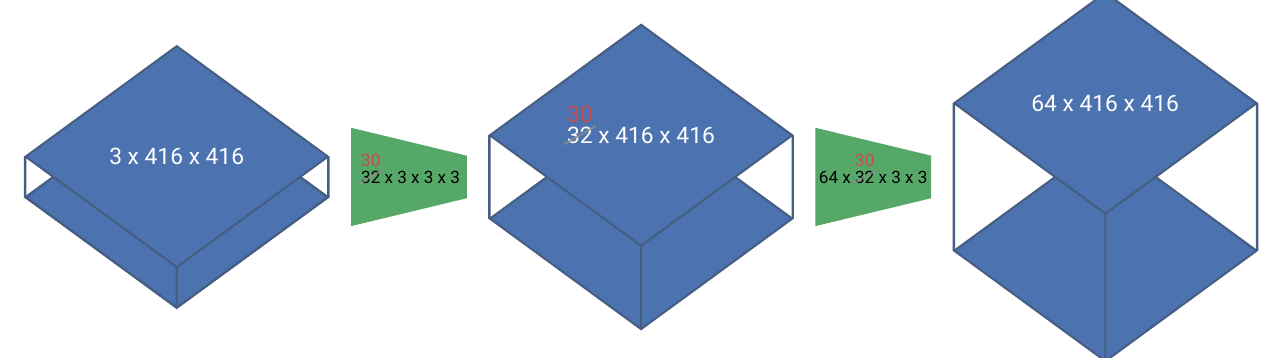
Figure 6. Dependency tracking when pruning convolutions. When reducing the number of channels of the first convolu- tional kernel ( green ), the number of output features ( blue ) changes as well. This means that we need to adapt any module that uses that feature map (i.c. the next